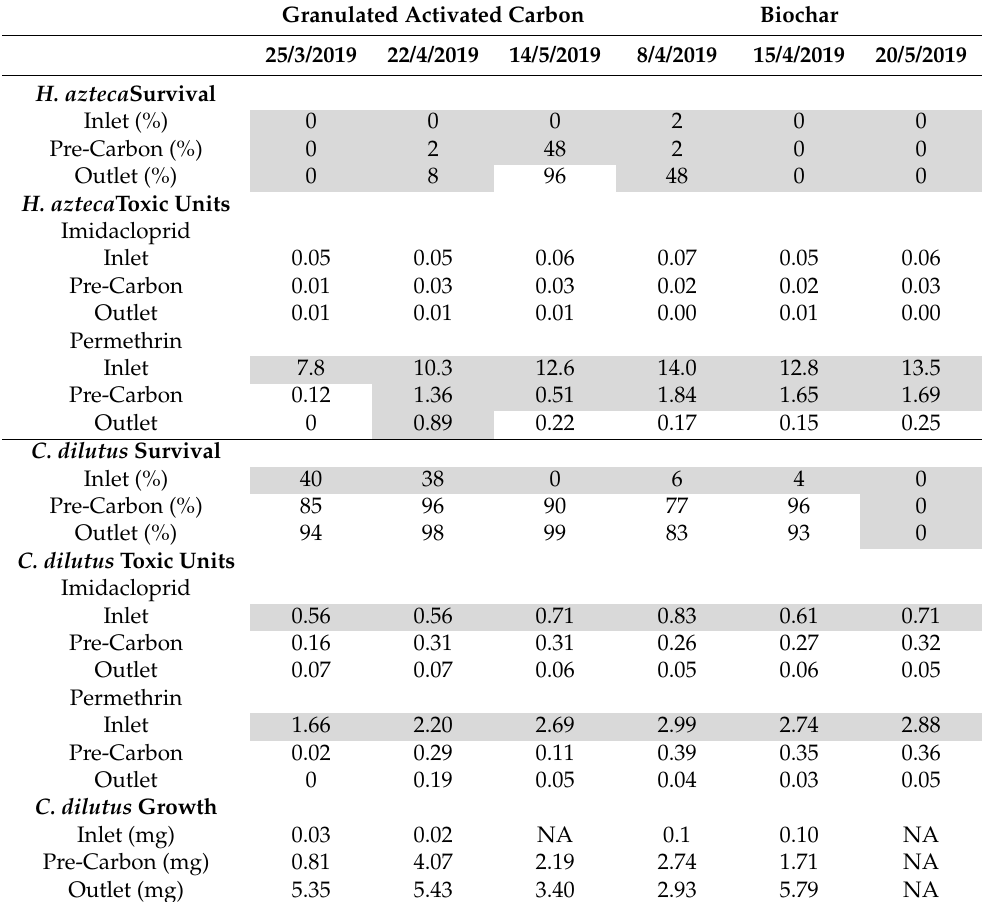
Table 2. Toxicity test results and related imidacloprid and permethrin toxic unit (TU) values based on insecticide concentrations measured in simulated runoff. Shaded cells indicate significant toxicity or toxic unit values greater than